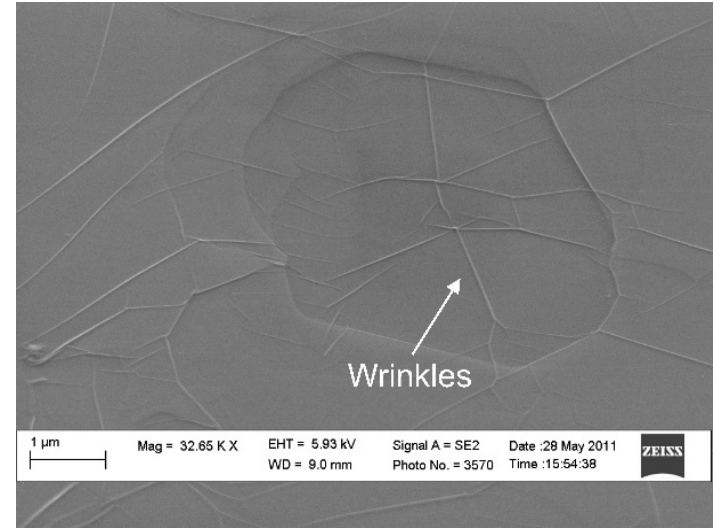
Figure 8. SEM image of graphene layers on SiC (not published results).